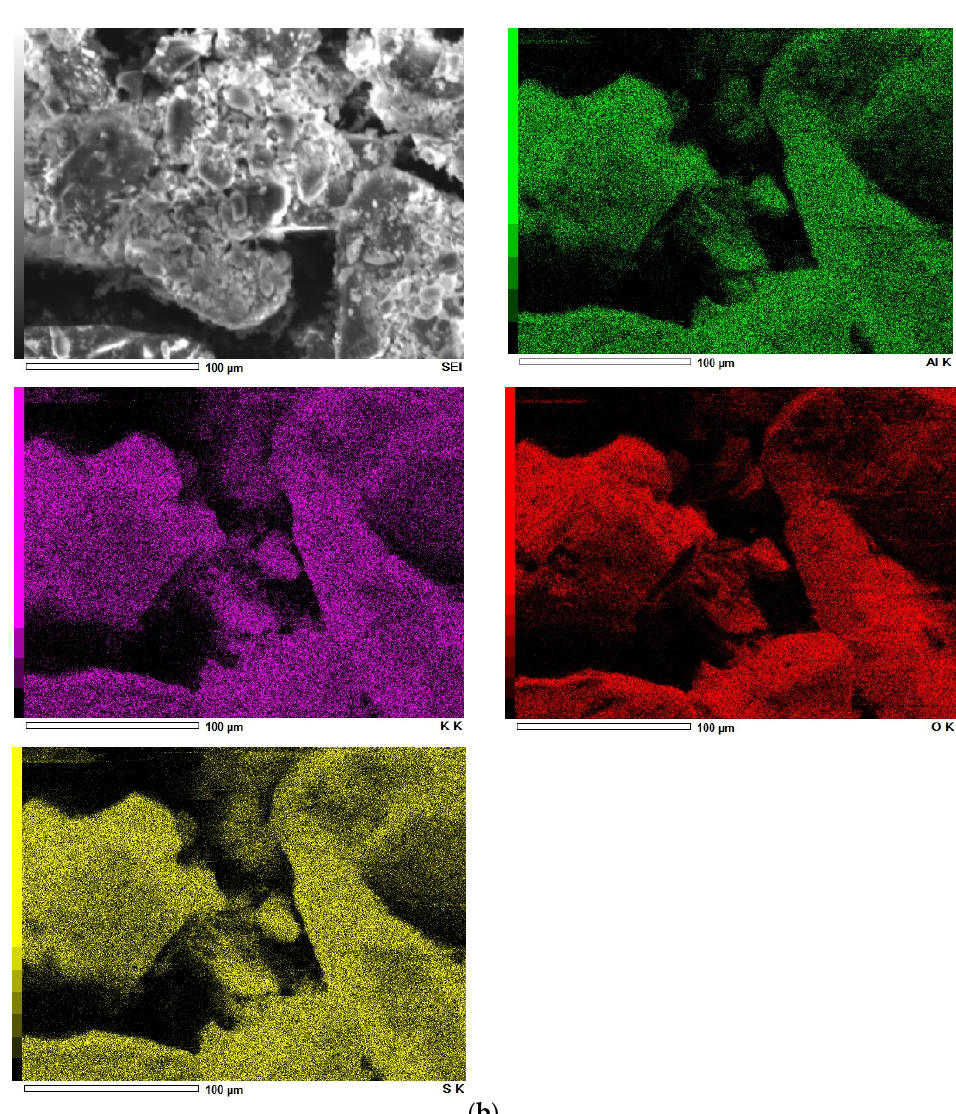
Figure 4. The XRF and EDX spectra of diatomite ( a ) and aluminium potassium alum ( b ).